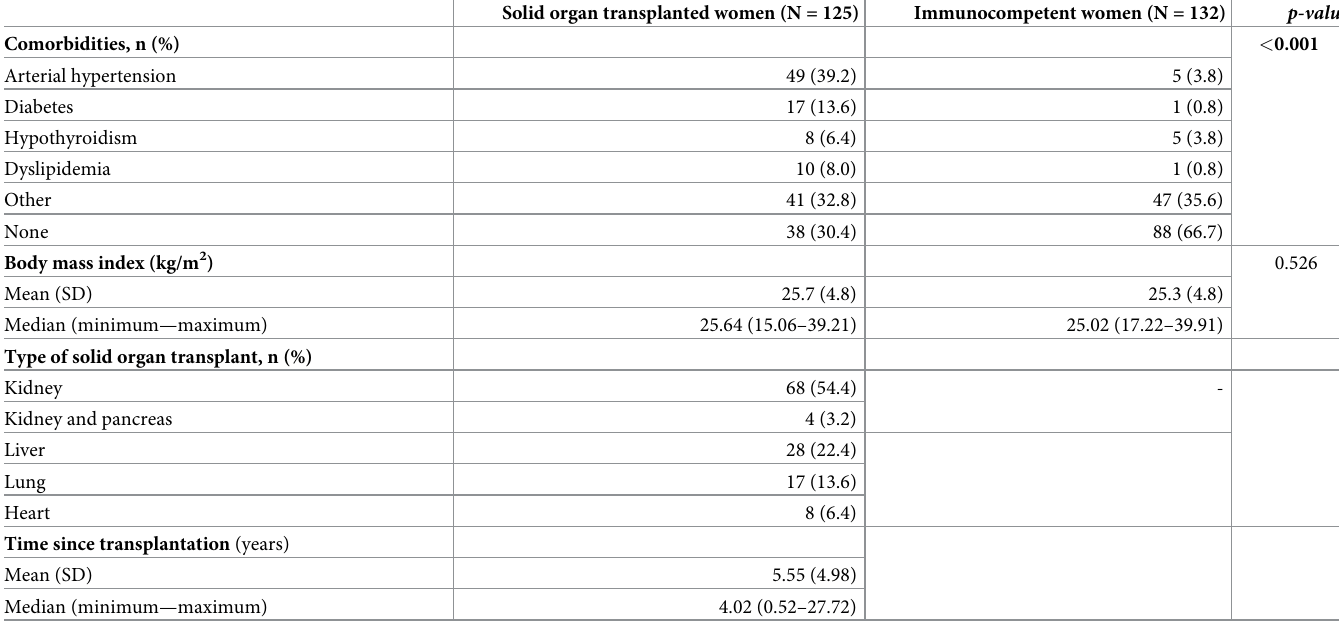
Table 4 shows the results of liquid-based cytology. SOT participants had higher prevalence of HPV-related cervical lesions (LSIL and HSIL) compared to immunocompetent women (15% versus 2.4%, p = 0.001). Multivariate logistic regression analysis of risk factors for cervical HPV with a variable iden- tifying SOT and controls was performed. Only variables with p < 0.2 in the bivariate analyses (S4 Table) were included in the multiple model: group (SOT or immunocompetent), years of schooling, smoking, hypothyroidism, dyslipidemia and body mass index. At first, we included all variables in the model and then took them out one by one, beginning with those with high p-value until the final model, which showed significant association of HPV detection with